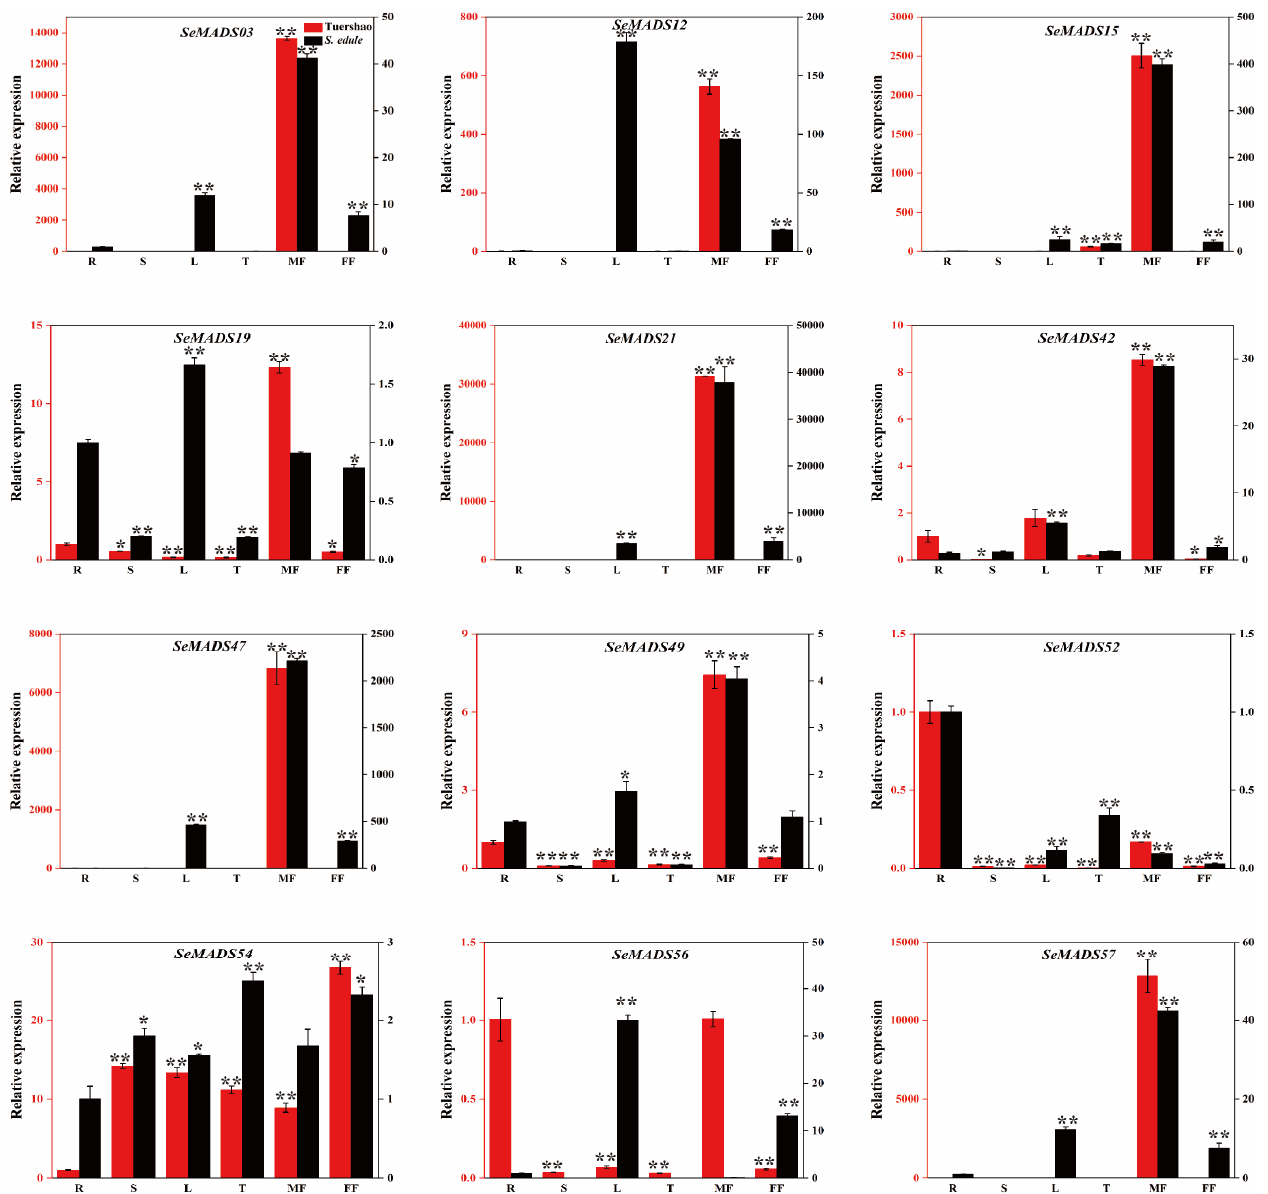
Figure 9. Expression of SeMADS-box genes of ‘Tuershao’ and S.edule in di ff erent tissues (R: Root, S: Stem, L: Leaf, T: tendril, MF: Male fl ower, FF: Female fl ower). Asterisks represent the signi fi cant di ff erence at the same developmental stage point (* p < 0.05; ** p < 0.01).